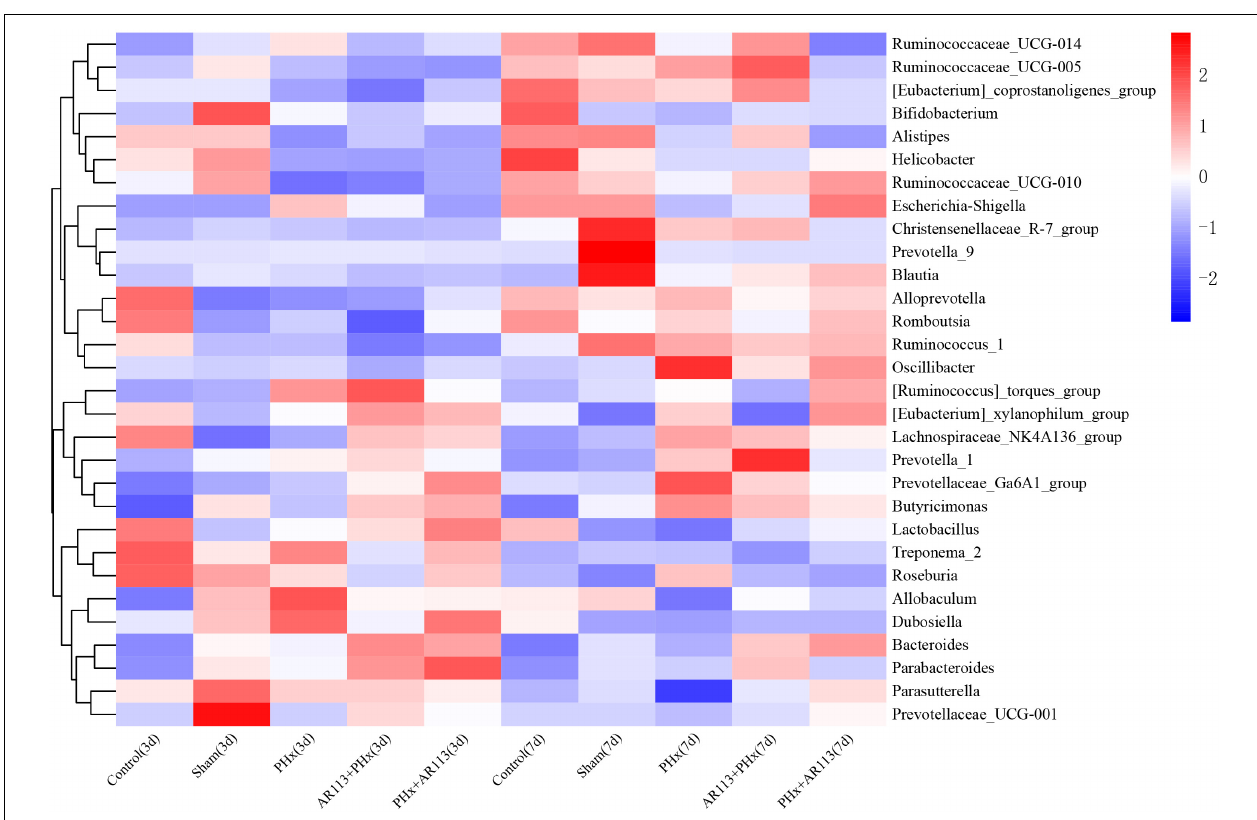
FIGURE 6 | Distribution of relative abundance at the genus level among Control, Sham, PHx3, AR113+PHx3, and PHx3+ AR113